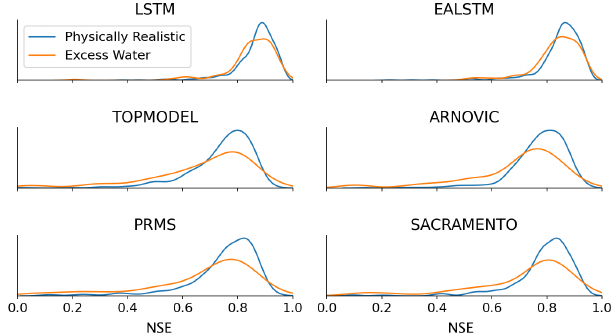
Figure 6. Comparing the NSE results for catchments that have excess water, where runoff deficits exceed total PET (orange), to those catchments that have physically realistic conditions (blue). The orange line shows the histograms for stations that fall below the curved line in the Budyko analysis above (the runoff deficit ex- ceeds total PET; therefore there is excess water in the model). The blue line shows the histograms for those stations between the two dashed